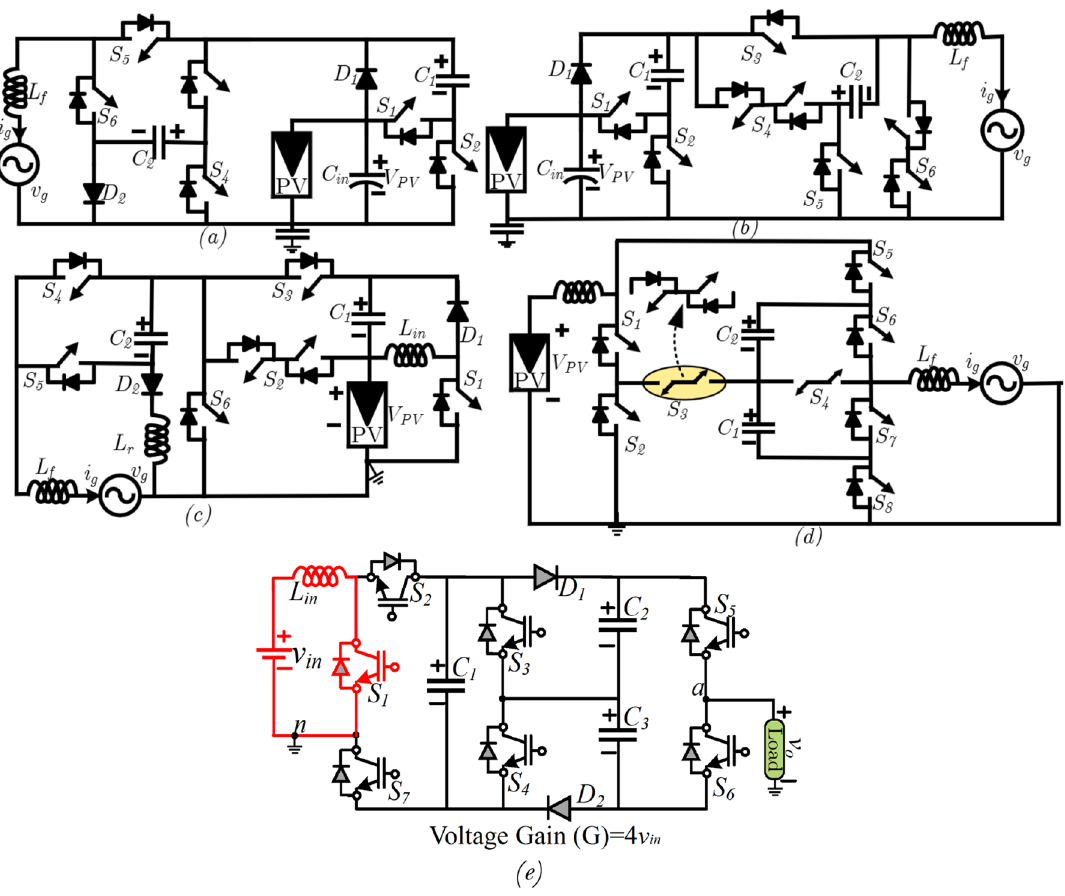
Figure 1. Various common ground 5L inverter circuit diagram ( a ) presented in 14 , ( b ) presented in 15 , ( c ) presented in 17 , ( d ) presented in 18 and ( e ) proposed 5L-QBT